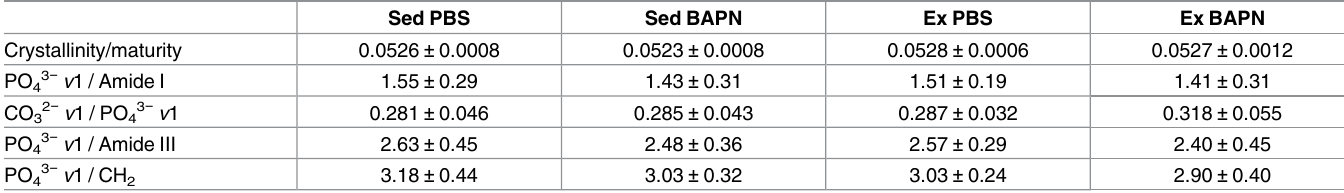
Table 1. Raman spectroscopy on medial surface of distal right tibiae.